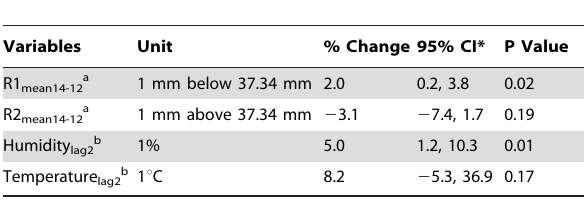
Table 2. Adjusted impact of climate variables on the ZCL incidence estimated by GEE